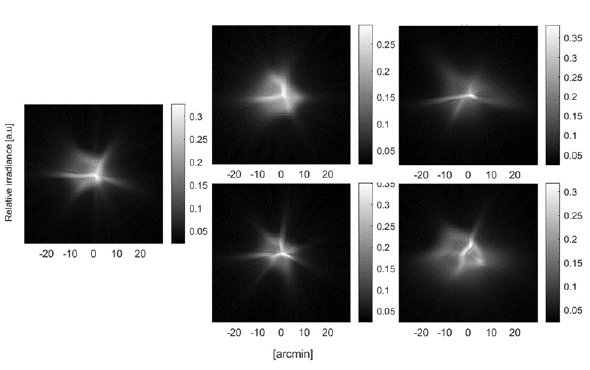
Figure 4. An example of Point Spread Function (PSF) obtained in the experiment. Left: Before reading task; center up: Emax; center down: Imax; right up: Emin; right down: Imin.